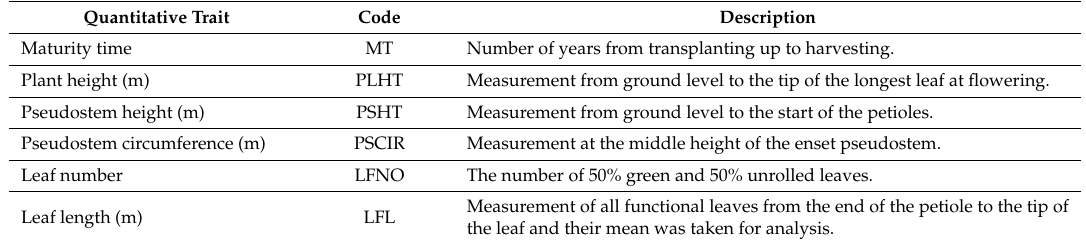
Table 9. List of quantitative characteristics recorded in the